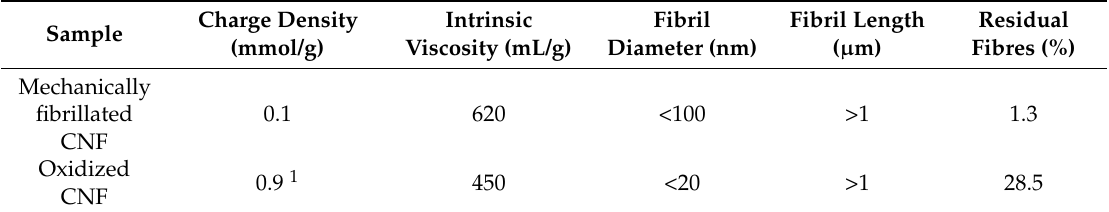
Table A2. Nanocellulose characteristics. All data, except residual fibres, are previously published in [25].